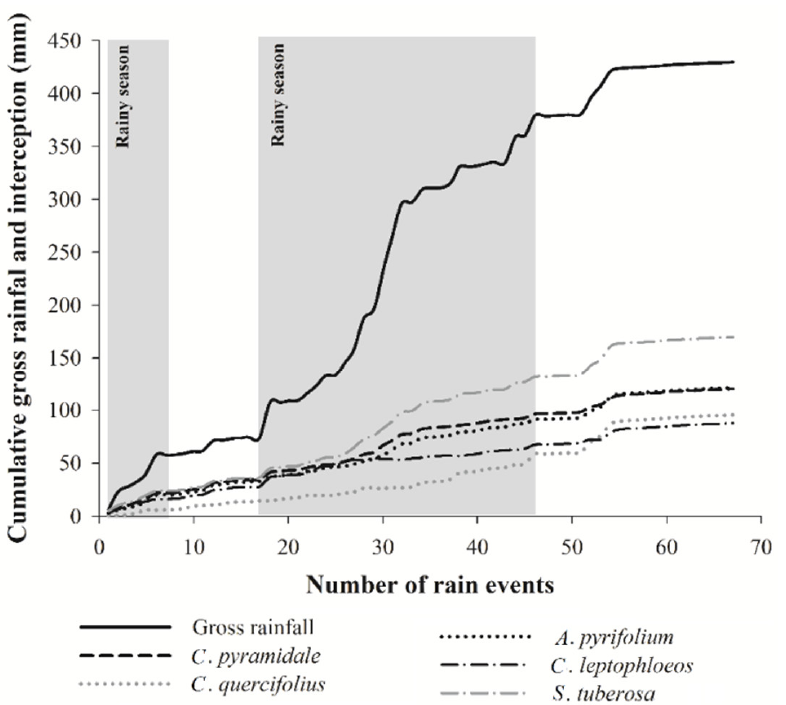
Figure 3. Cumulative measured gross rainfall and interception values from March 2016 to September 2017 at the Caatinga domain in Brazil.